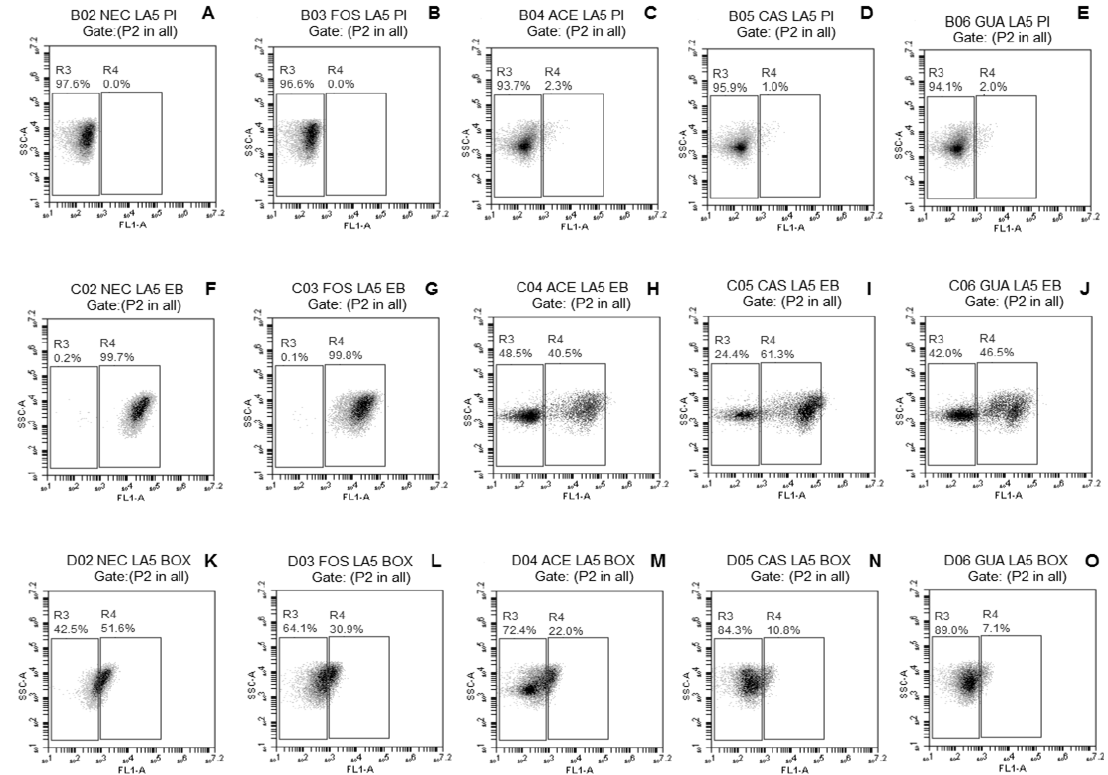
Figure 3. Fluorescence density plots of L. acidophilus LA-05 in response to staining with PI ( A – E ), EB ( F – J ), and DiBAC 4 (3) ( K – O ) after freeze-drying in the absence (NEC, ●) or presence of fructo-oligosaccharides (FOS, ■ ) or processing coproducts of acerola (ACE, □), cashew (CAS, ▵ ), or guava (GUA, ○ ). LA-05 — L. acidophilus LA-05. The vertical axis indicates the fluorescence intensity of PI, EB, and DiBAC 4 (3) and the intensity of lateral light dispersal. The subpopulation of negative stains was blocked in the left rectangles; the positive subpopulation of the stains was delimited in the right rectangles. The percentages of cell subpopulations that fell on each port are shown in each plot.